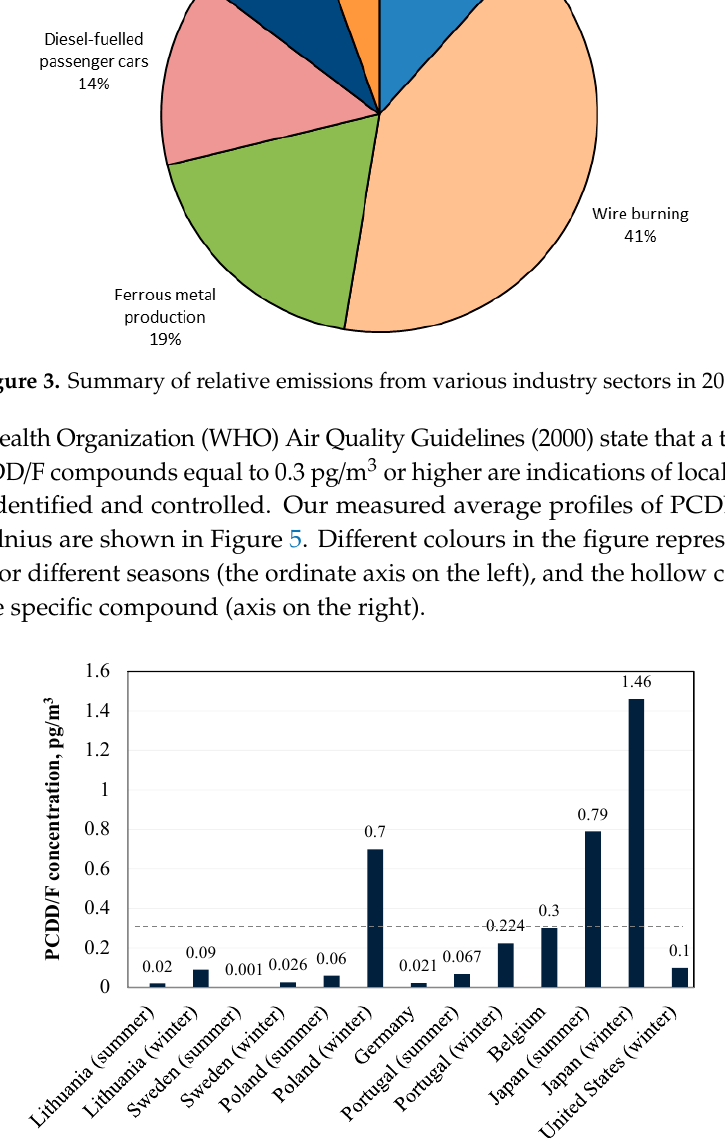
Figure 4. Atmospheric PCDD / F in urban regions of various countries. Dashed lines represent the accepted limits on presence of PCDD / F in air in various countries.